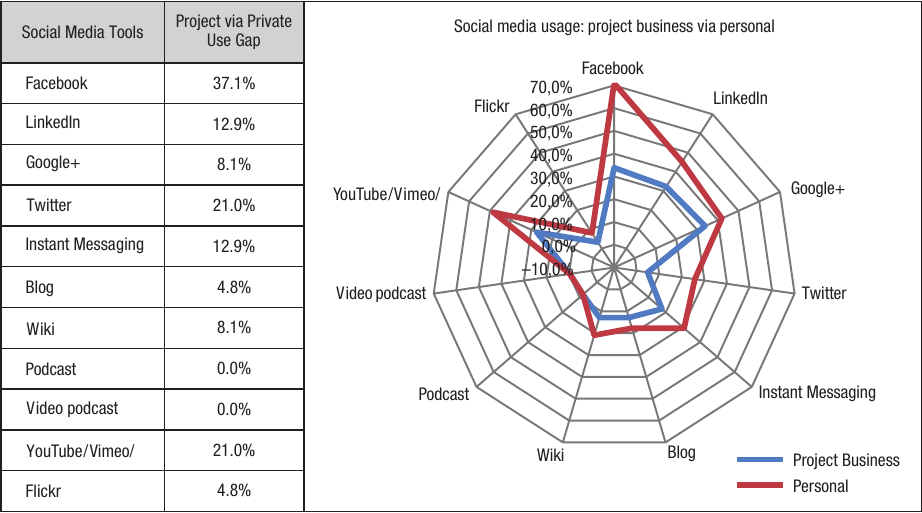
Fig. 8. Social media usage with purpose of project business